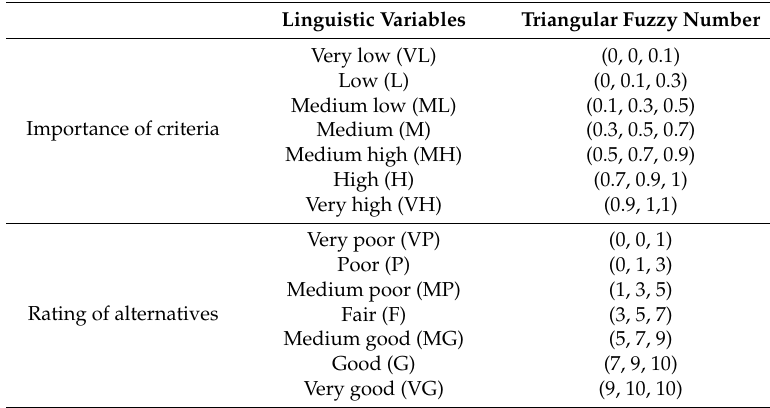
Table 1. The linguistic variables and their fuzzy equivalents.